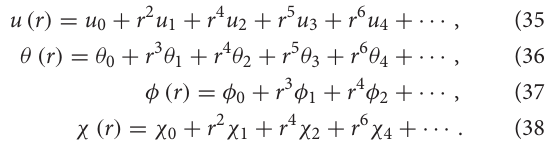
FIGURE 3 | Temperature curves for multiple values of T b , T t .